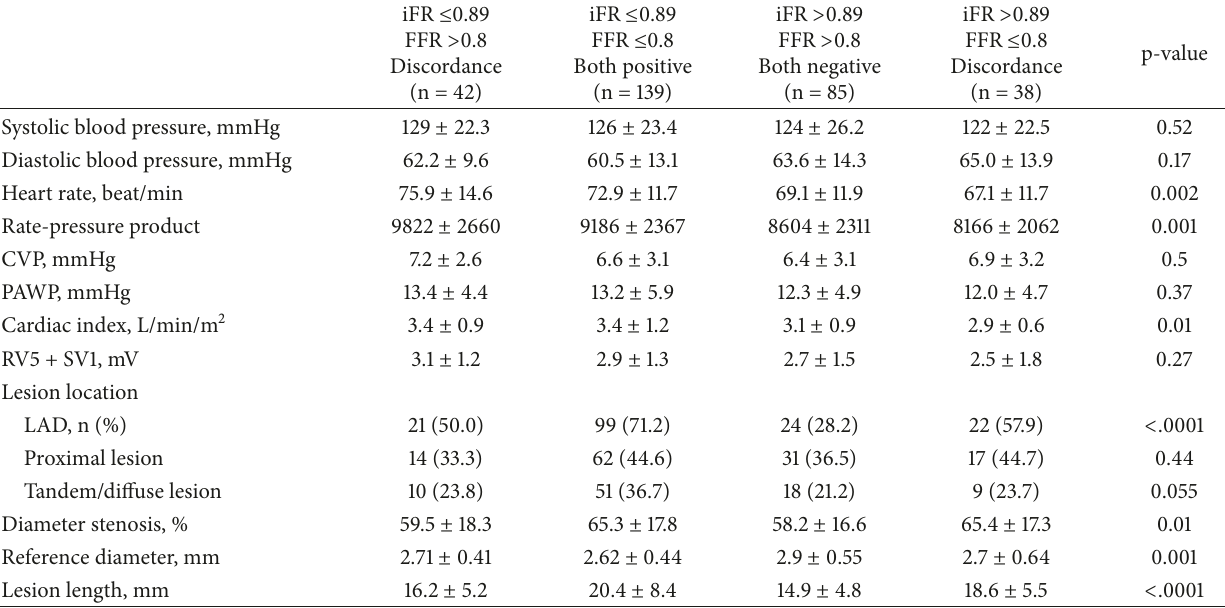
Table 3: Hemodynamic and lesion factors for iFR and FFR in the concordant and discordant groups. iFR ≤